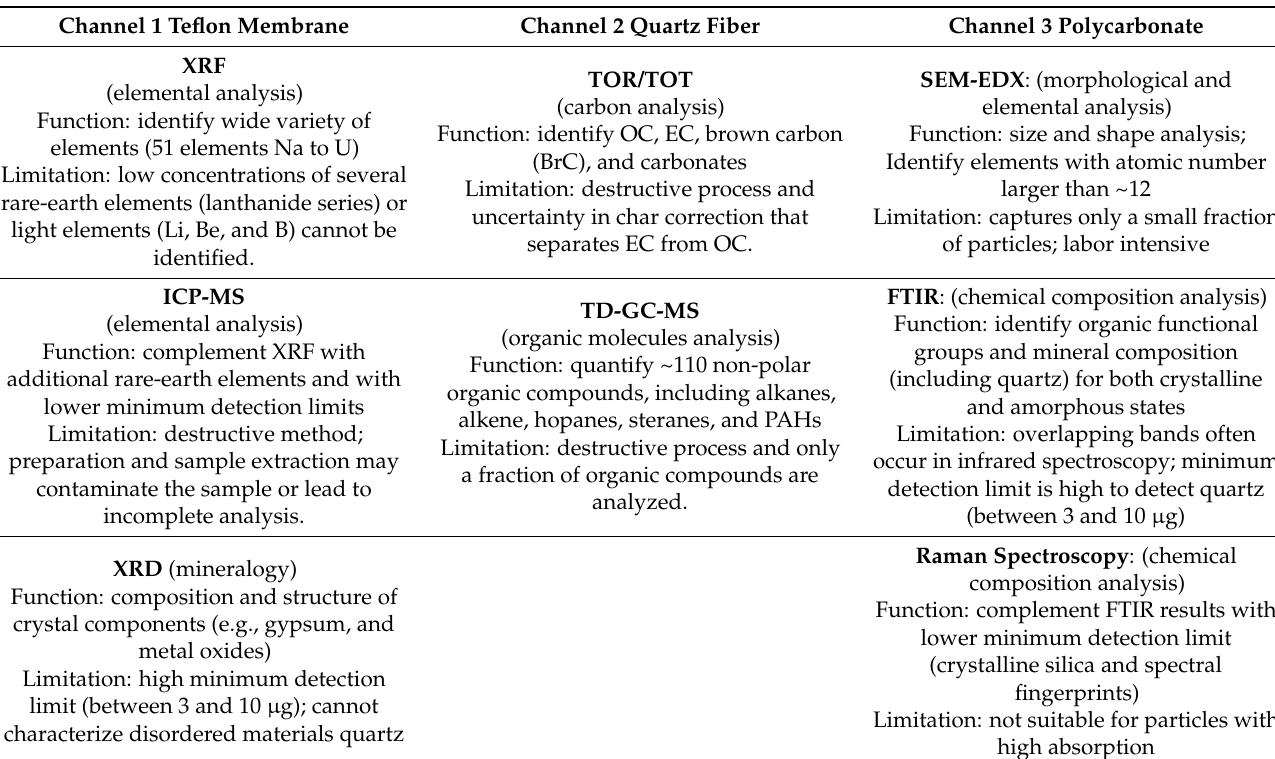
Table 7. Comprehensive chemical and morphological analyses for Teflon membrane, quartz fiber, and polycarbonate membrane filter